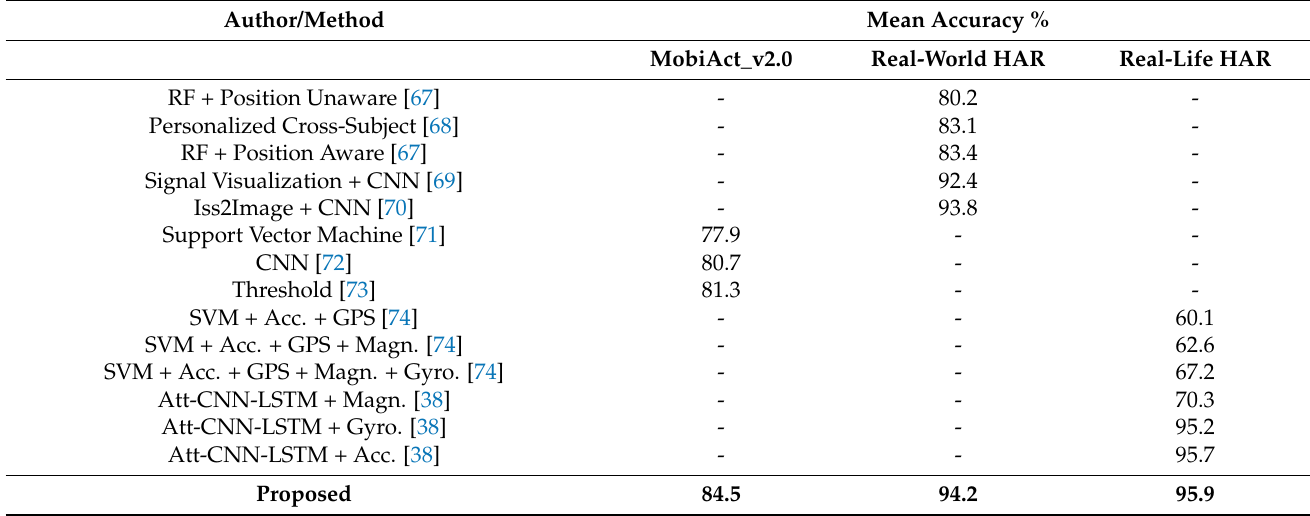
Table 6. Comparison of proposed SSRDC system with available state-of-the-art